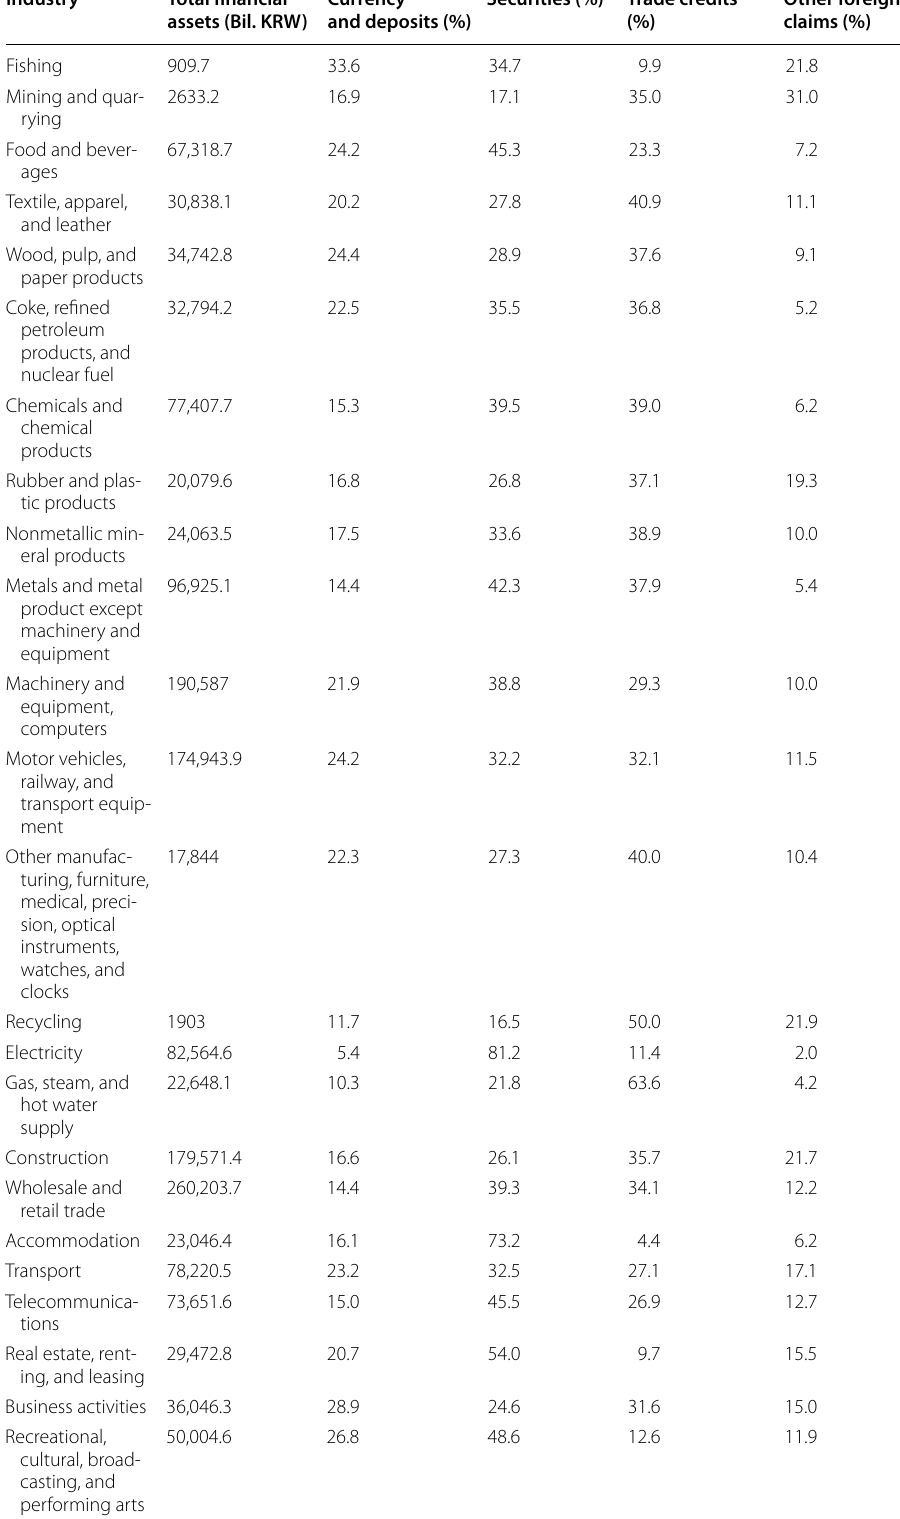
Table 6 Inter-industry financial asset portfolio in 2005 Industry Total financial Currency Securities (%) Trade credits Other foreign assets (Bil. KRW) and deposits (%) (%) claims (%) Fishing